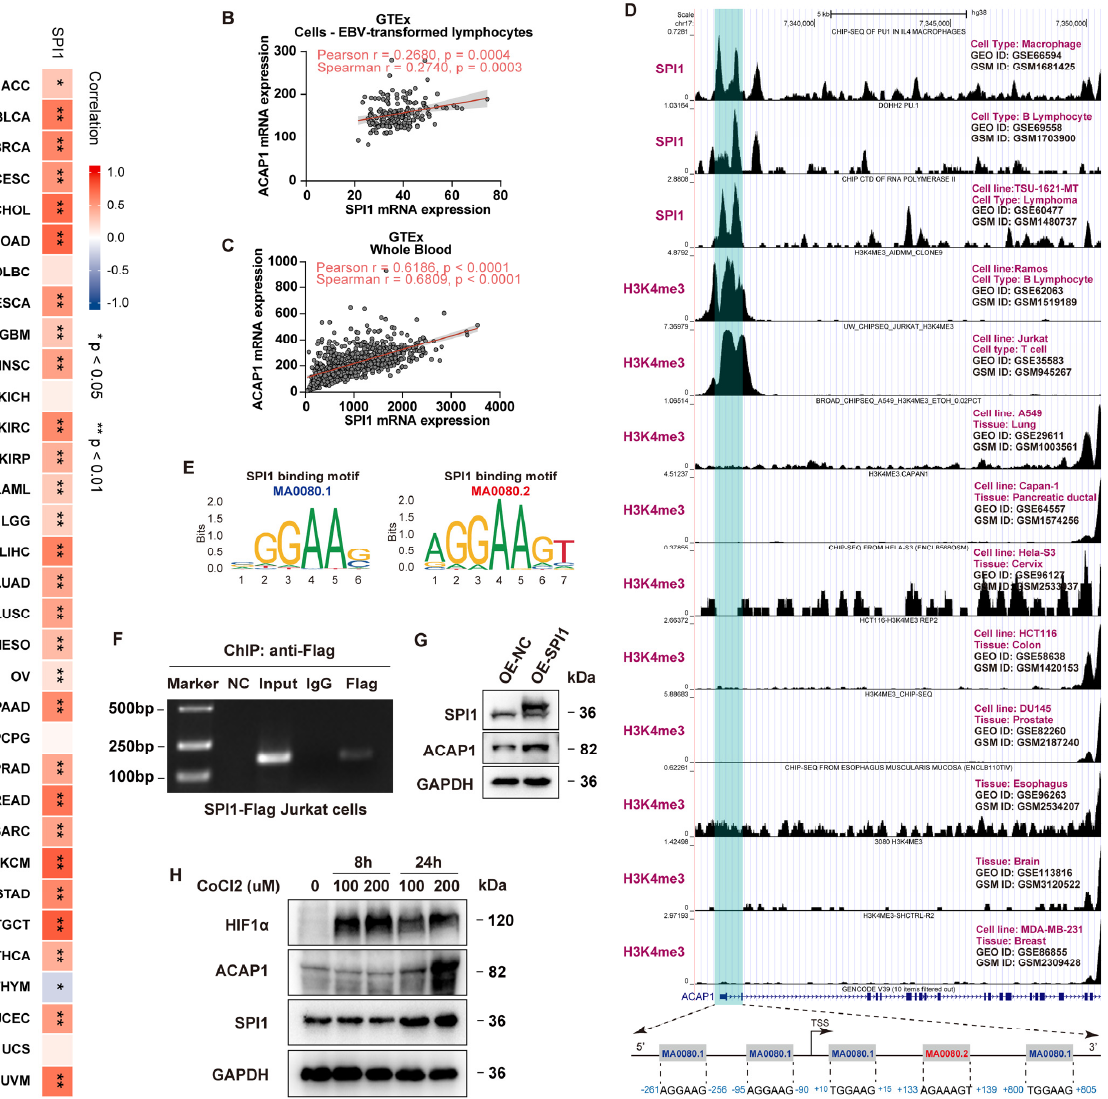
Figure 6. Transcriptional regulation of ACAP1 by SPI1. ( A ) Heatmap of the correlation coefficient of ACAP1 mRNA levels and SPI1 levels across 33 cancer types in TCGA. ( B ) Scatter plot displays the SPI1 and ACAP1 mRNA expression in EBV-transformed lymphocytes of GTEx dataset. ( C ) Scatter plot displays the SPI1 and ACAP1 mRNA expression in whole blood of GTEx dataset. ( D ) ChIP-sequencing peaks of SPI1 in macrophage, B lymphocyte, and lymphoma; H3K4me3 in Ramos B-lymphocytes, Jurkat T-cell, A549 lung cancer cells, Capan-1 pancreatic ductal cancer cells, Hela-S3 cervix cancer cells, HCT116 colon cancer cells, DU145 prostate cancer cells, esophagus cells, brain cells, and MDA-MB-231 breast cancer cells. The binding region of SPI1 on ACAP1 promoter is highlighted in cyan shaded box. The SPI1 binding sites on ACAP1 promoter predicted by JASPAR are shown. ( E ) SPI1 binding motif MA0080.1 and MA0080.2 from JASPAR curated motif database. ( F ) ChIP-PCR showed SPI1 binds to the promoter of ACAP1 in Jurkat cells. ( G ) Analysis of SPI1 overexpression on ACAP1 protein expression in Jurkat by Western blotting. ( H ) Effects of hypoxia-mimicking CoCl 2 treatment on HIF1 α , SPI1, and ACAP1 expression in Jurkat cells were determined by Western blotting,** p < 0.01, * p < 0.05. Taken together, our results suggest that ACAP1 expression is positively modulated by CNV and SPI1 but negatively regulated by promoter methylation.